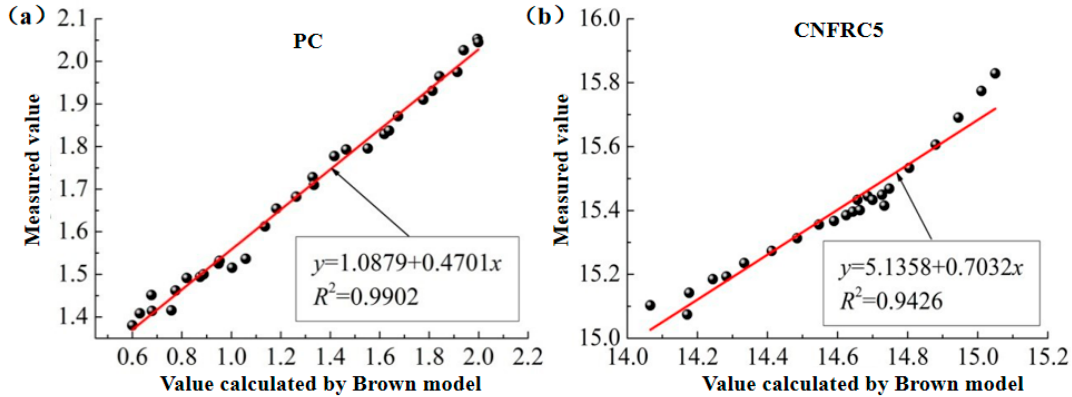
Figure 11. The fitting for relation between measured values and calculated values for ε „ based on Brown model. ( a ) PC; ( b ) CNFRC5.